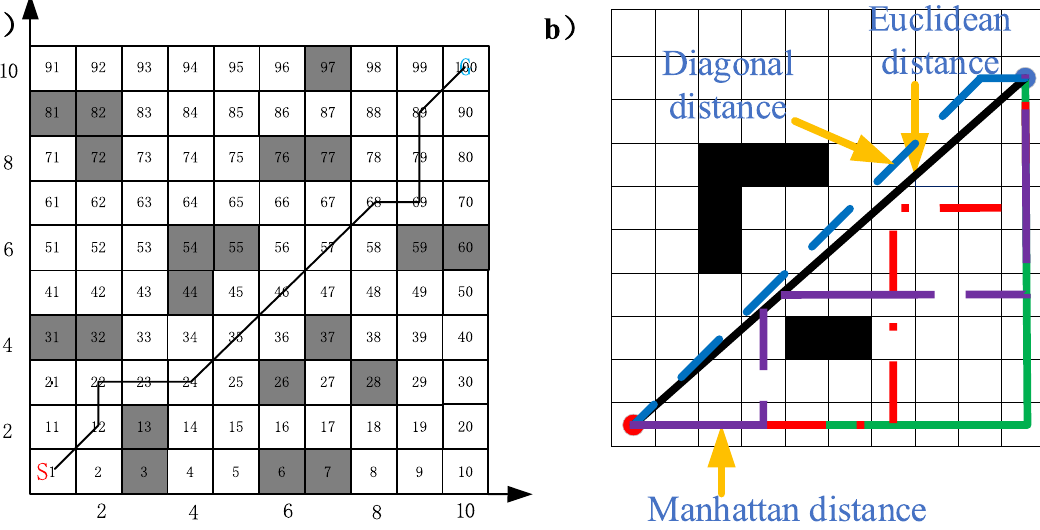
Figure 1. ( a ) Schematic diagram of grid method ( b ) Paths generated by different distance